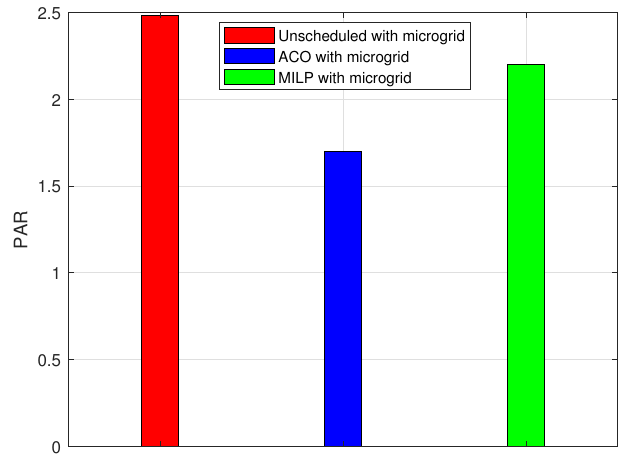
Figure 20. PAR minimization evaluation considering microgrid. Carbon emission minimization evaluation considering microgrid is depicted in